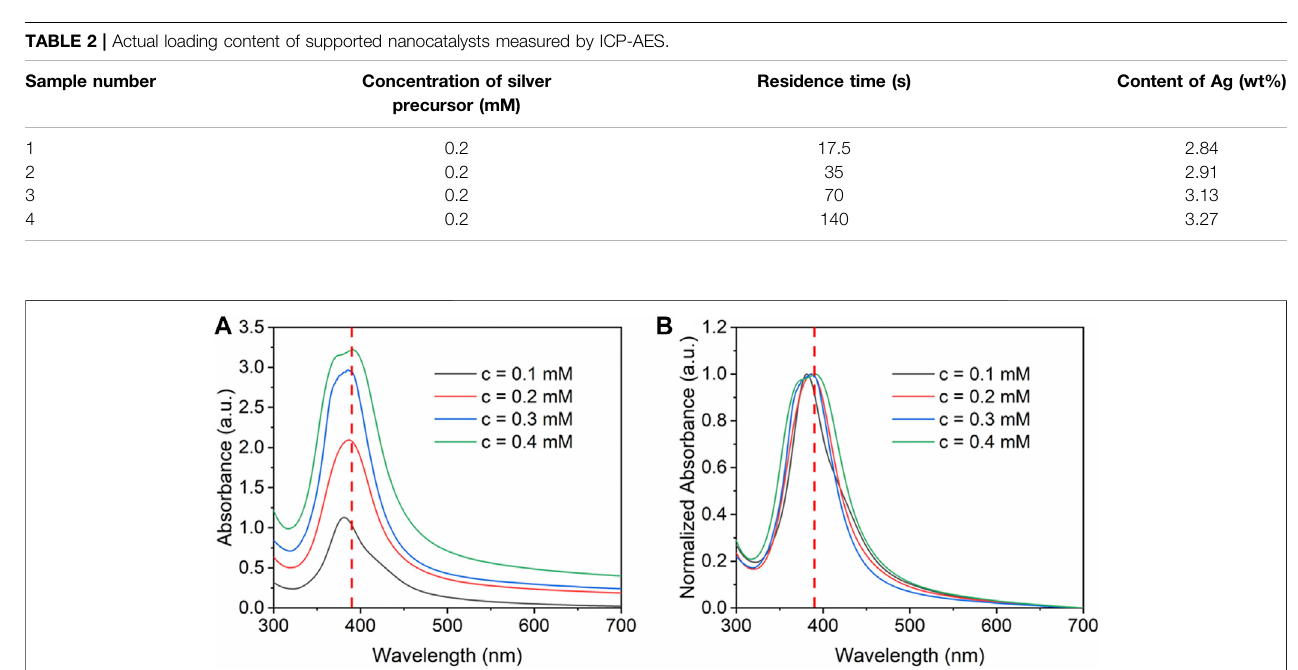
Frontiers in Chemistry |